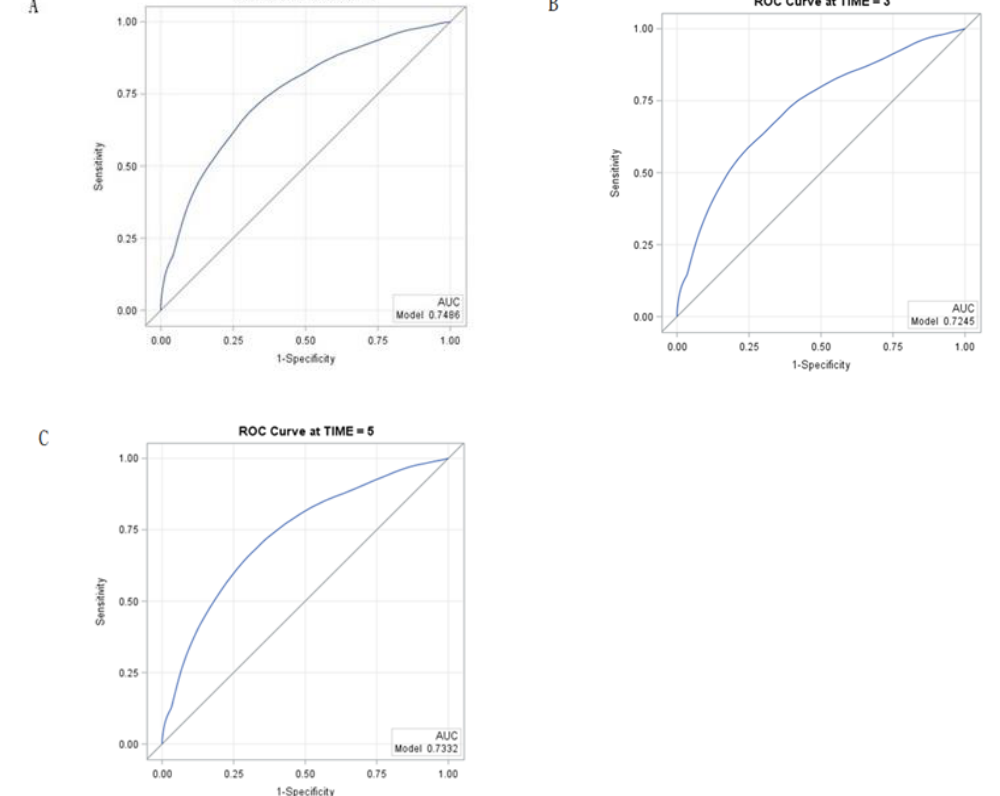
Figure 4. Time-dependent ROC curves at ( A ) 1 year, ( B ) 3 years, and ( C ) 5 years, to assess predictive accuracy for overall survival. ROC, receiver operating characteristic; AUC, area under curve.